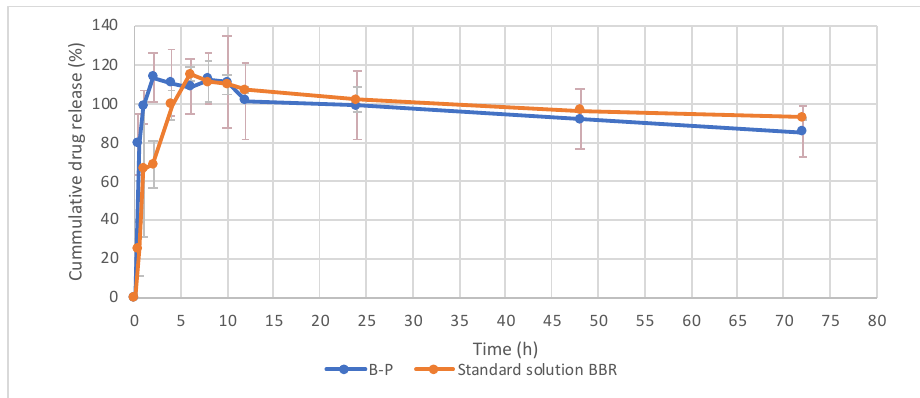
Figure 7. Cumulative release profile of berberine from LCNs. Each value represents mean ± SD (n = 3). B-P refers to berberine–phytantriol nanoformulation; BBR refers to standard berberine.